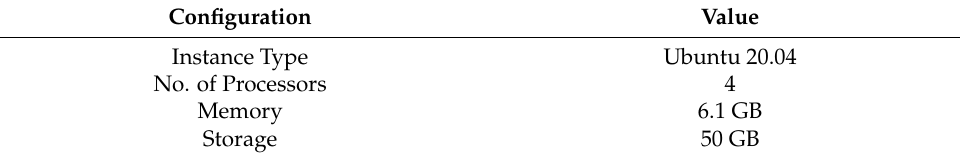
Table 2. System configuration of the local virtual machine setup.